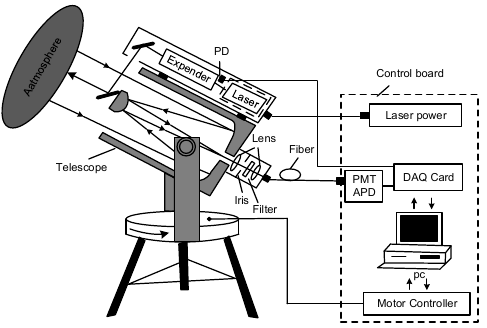
Figure 1. Composition diagram of aerosol